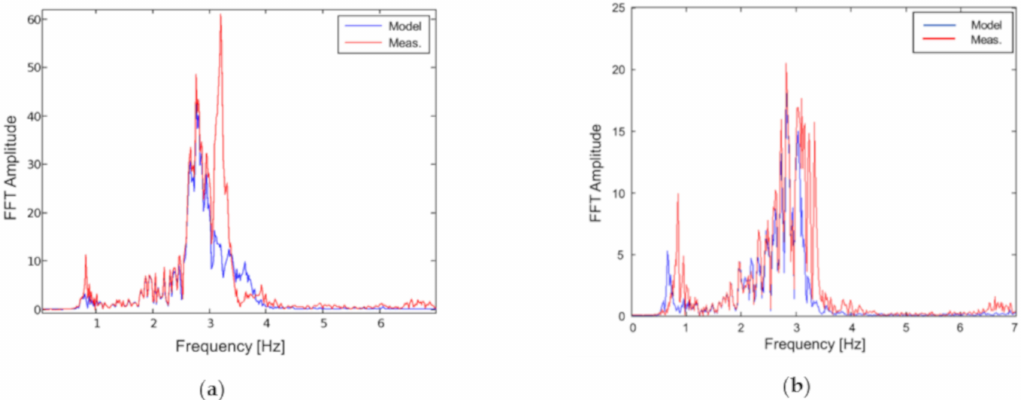
Figure 13. ( a ) Fourier transforms of on-site data and model 12, accelerometer 14, event 12. ( b ) Fourier transforms of on-site data and model 40, accelerometer 14, event 72.